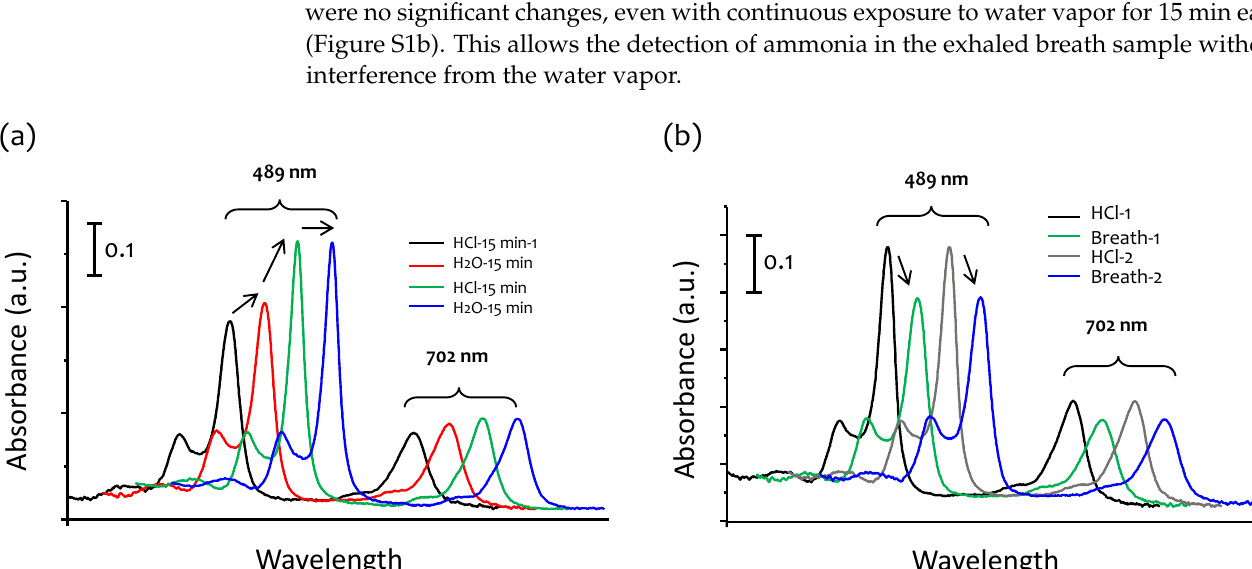
Figure 5. ( a ) UV–vis spectra of the PDDA/TSPP film: the black line represents the signal after exposure to HCl for the first 15 min, the red line represents exposure to the H 2 O vapor for 15 min after the first HCl exposure, the green line represents exposure to HCl for the second 15 min, and the blue line represents exposure to H 2 O for 15 min following HCl exposure. ( b ) UV–vis spectra of the PDDA/TSPP film measured after exposure to a 0.1 M HCl vapor (black and grey lines) and after exposure to breath for 10 s (green and blue lines). The spectra are shifted horizontally for illustration purposes and convenience in reading the figures.